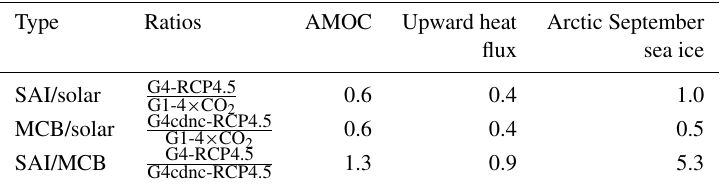
Figure 11. Model mean Arctic September sea ice area (10 6 km 2 ) over the 40-year analysis period (defined as the limit of 15% ice concen- tration region). The lines are the linear regression trend lines of AMOC intensity and Arctic September Sea ice area over the 40-year analysis period for each ESM. Those significant at the 95% level are shown as heavier lines, and the ESMs are labeled in bold in the legend. Table 4. Across-ESM ensemble mean relative efficacy ratios of geoengineering compared to their efficacy in changing TOA radiation. Where individual ESM have no data, the ensemble mean was